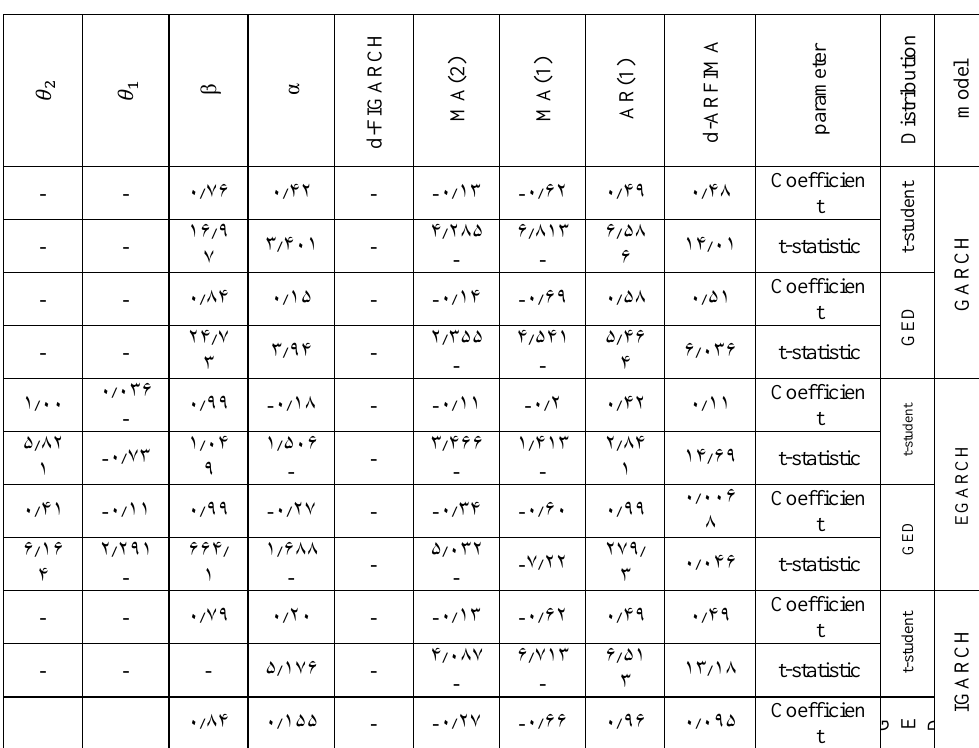
Table 6. GARCH models of the chemical product industry